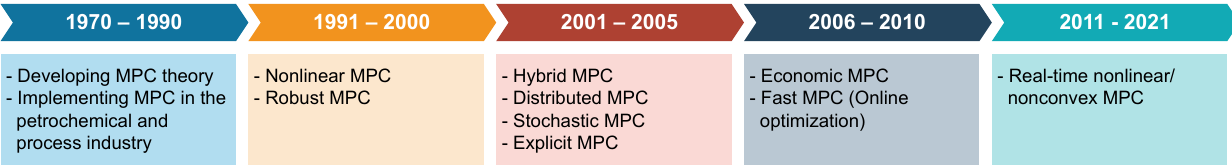
Figure 1. Timeline of MPC development and